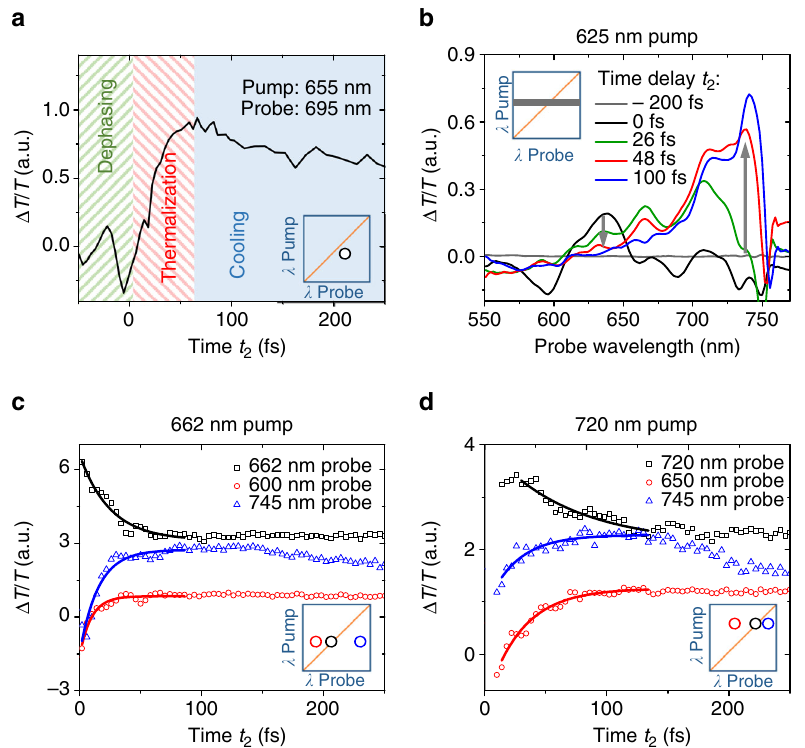
Fig. 3 Carrier thermalization in perovskites. a 2D electronic spectroscopy (2DES) kinetic at 655 nm pump and 695 nm probe wavelength, which is on the right side of the 2DES map diagonal and thus between the pump wavelength and the bandgap (excitation density: 2 × 10 18 cm − 3 ). We observe three different regimes: a coherent regime at negative times during which we observe spectral oscillations, a thermalization regime during which we observe a rise in signal much slower than the temporal width of the instrument response function and delayed relative to the rise of the diagonal, and a carrier cooling regime during which the signal slowly decays. b Δ T / T spectra for 625 nm pump wavelength extracted from 2DES maps for different time delays t 2 at an excitation density of 2 × 10 18 cm − 3 . Initially, we observe a peak around the pump energy. Carriers quickly thermalize and form a Boltzmann distribution. c , d Kinetics of carrier thermalization for c 662 nm and d 720 nm pump wavelength at an excitation density of 2 × 10 19 cm − 3 . While the diagonal signal decays, the off-diagonal signals rise indicating that carriers scatter from the initial sharp energy distribution into a broad statistic energy distribution. The lines represent a mono-exponential fi t to the experimental